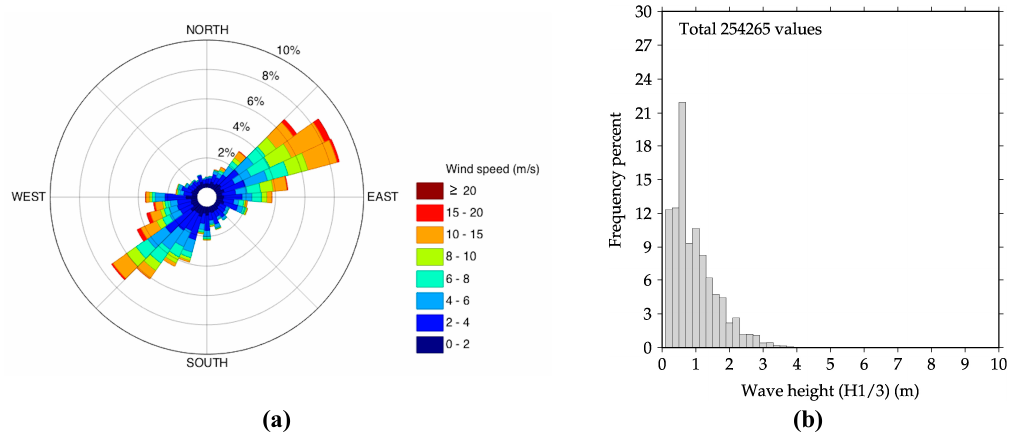
Figure 3. (a) Wind speed and direction and (b) significant wave height, from data collected by the Côte d’Azur meteorological buoy (Météo-France) located 2 nmi from BOUSSOLE.